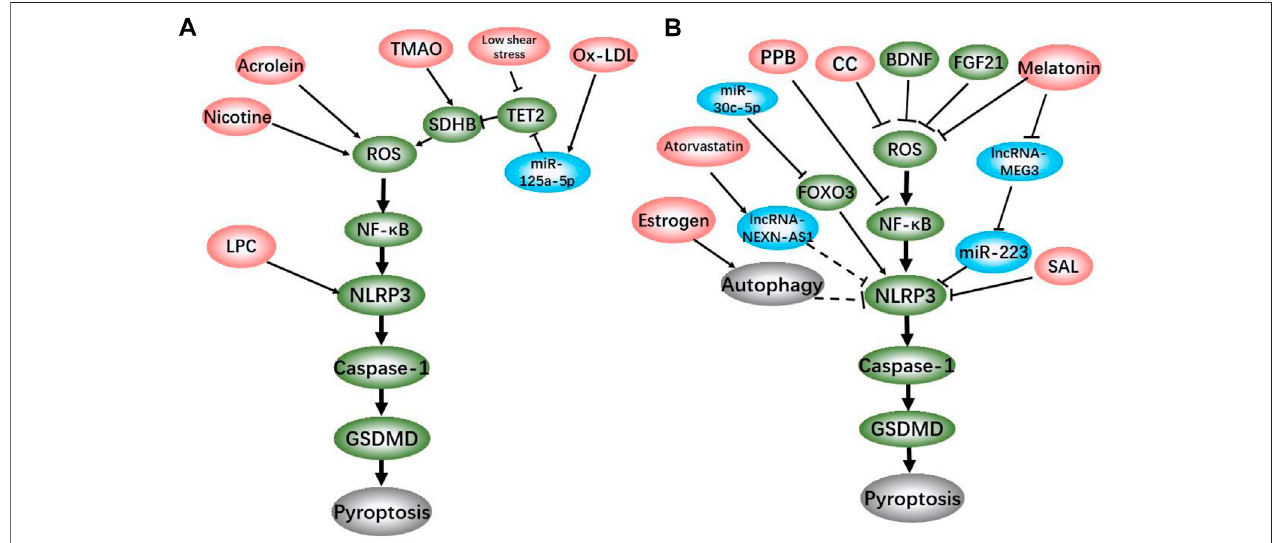
FIGURE 1 | Positive factor (A) and Negative factor (B) regulating pyrotosis in